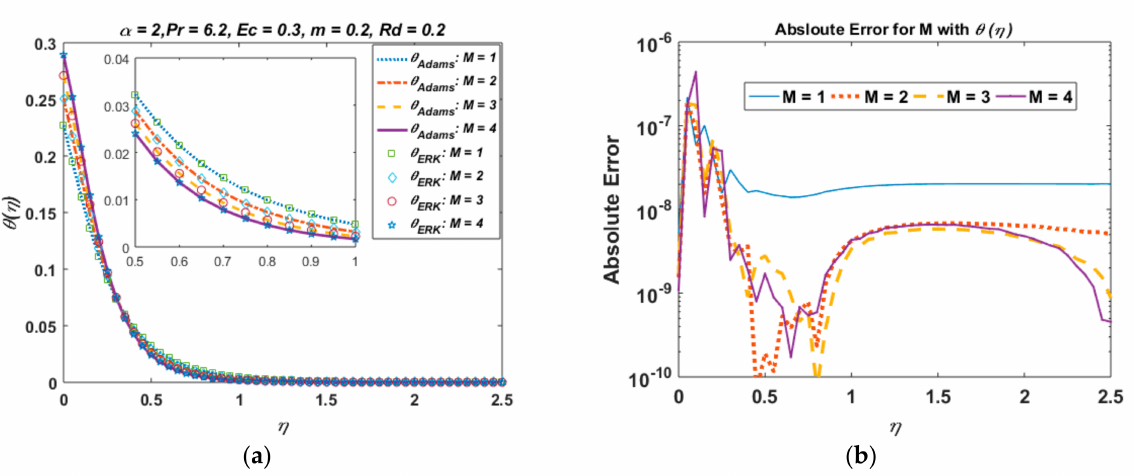
Figure 3. Temperature profile and absolute error for varying values of M . ( a ) Temperature profile with Adam–Bashforth and explicit Runge–Kutta method. ( b ) Absolute